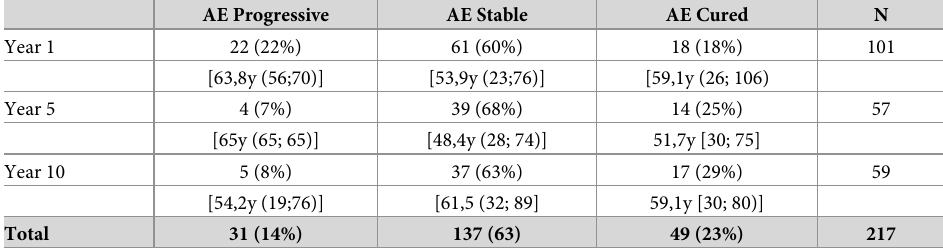
Table 7. Alveolar echinococcus (AE) patients staged into groups with progressive, with stable and cured disease. The mean age with minimum and maximum ist indicated in brackets. The average age was 58.7 years. The two youn- gest patients were 19, the oldest patient 106 years old. One third of the patients were between 61 and 75 years old at the time of blood collection, and 51% percent of the patients were female. The youngest age group (0-30years) was the smallest with 8%, and the higher age groups of 31-45y, 46-60y, 61-75y and 76+y represented 16%, 24%, 36% and 16% of all AE patients,